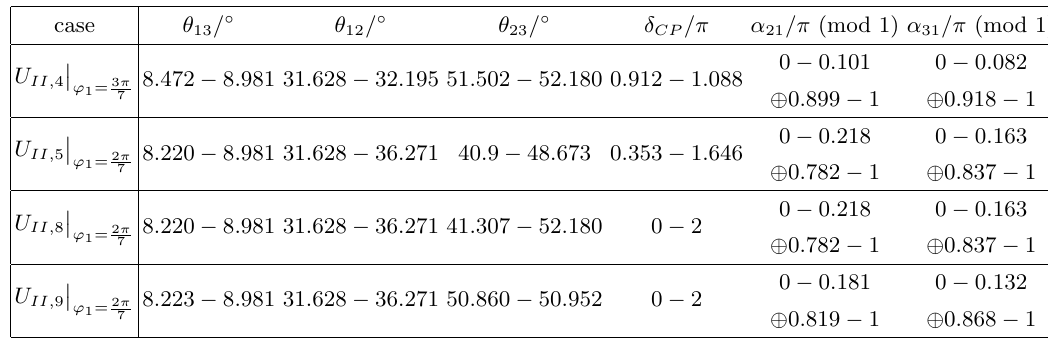
Table 8 . The allowed ranges of the mixing parameters for the viable mixing patterns U II; 4 , U II; 5 , U II; 8 and U II; 9 , and the (cid:13)avor symmetry group is D 7 such that the viable values of ’ 1 are 2 (cid:25)= 7 and 3 (cid:25)=